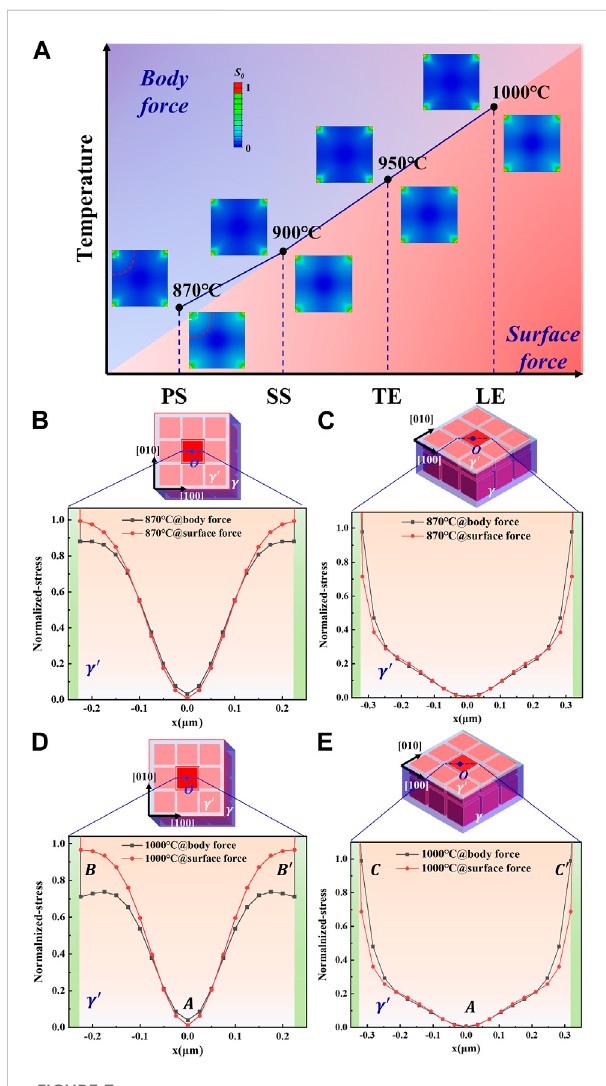
FIGURE 7 Microscopic stress distribution at the γ − γ ′ interface under the surface force and thebody force; (A) comparison of stress distribution atthe γ − γ ′ interfaceunderthesurfaceforceandthebodyforceatthe same temperatures, (B , C) stress distribution curves on the horizontal (B) and diagonal (C) lines of γ ′ precipitates at 870 ° C, respectively, and (D , E) stress distribution curve on the horizontal (D) and diagonal (E) lines of γ ′ precipitates at 1000 ° C,